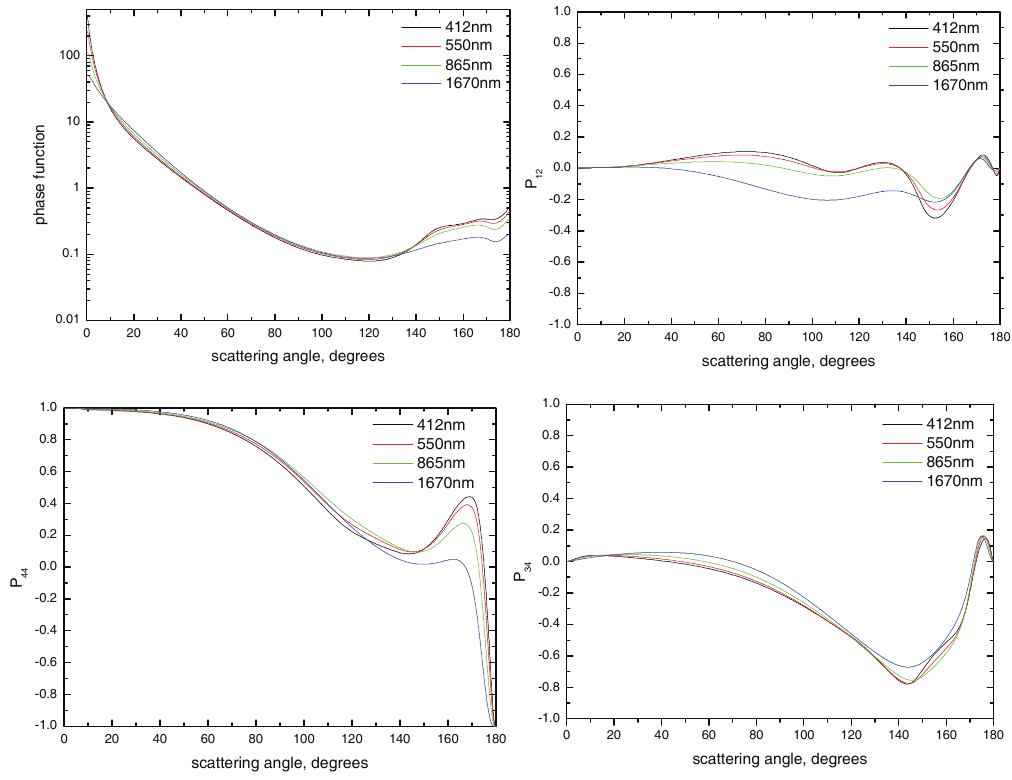
Fig. 3. Phase function and normalized phase matrix elements. compared to the value at 412 nm. The phase function is also only weakly dependent on the wavelength in the visible (see Fig. 3). The degree of polarization ( p =− P 12 , see Fig. 3) is smaller than 30%. Therefore, particles only weakly polarize incident solar light. The element P 34 takes quite large val- ues in the region 140–160 ◦ , which indicates the large size of particles and their spherical shape. Generally (with the ex- ception of P 44 around 170 ◦ ) the phase matrix elements do not have a pronounced spectral dependence, which is char- acteristic of large aerosol